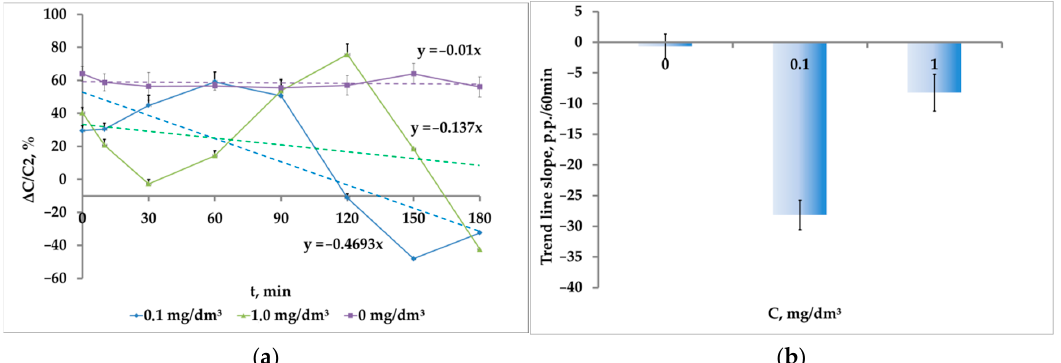
Figure 9. Approximation of ΔС / С 2 dynamics and ( a ) the slope of fitting lines ( b ) under the influence of various concentrations of nanoplastics on M. salina .